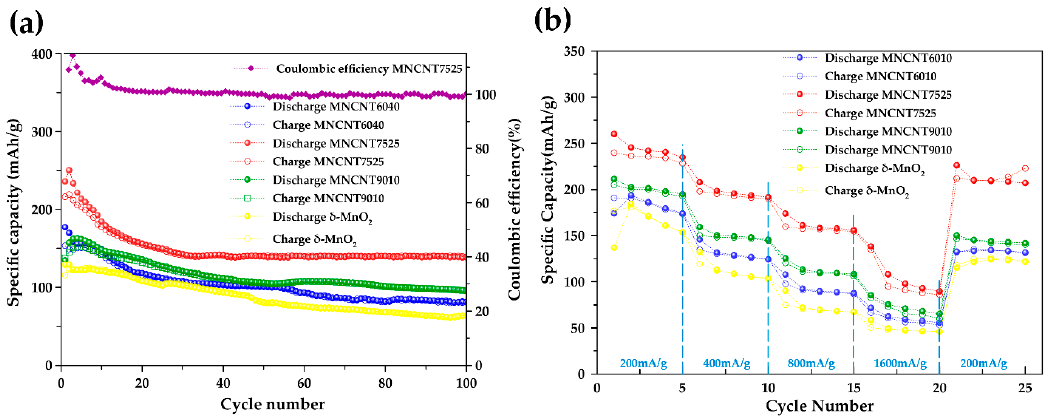
Figure 5. Performances of the batteries: ( a ) Cycling performance of the batteries at 400 mA g − 1 and ( b ) Rate capability of the batteries at different discharge/charge rates.